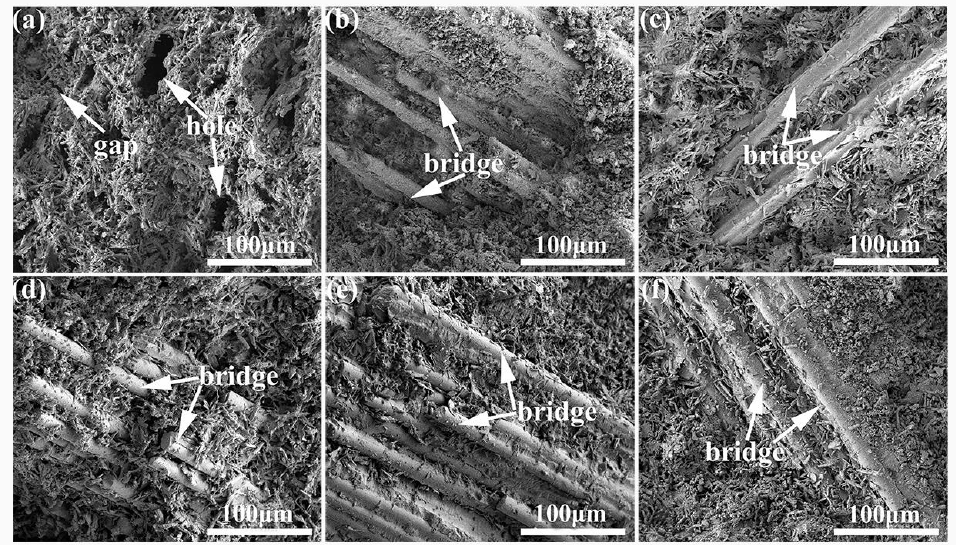
Figure 9. The SEM images of all the PBGC. ( a ) PBGC-NWF; ( b ) PBGC-UWF; ( c ) PBGC-MWF1; ( d )